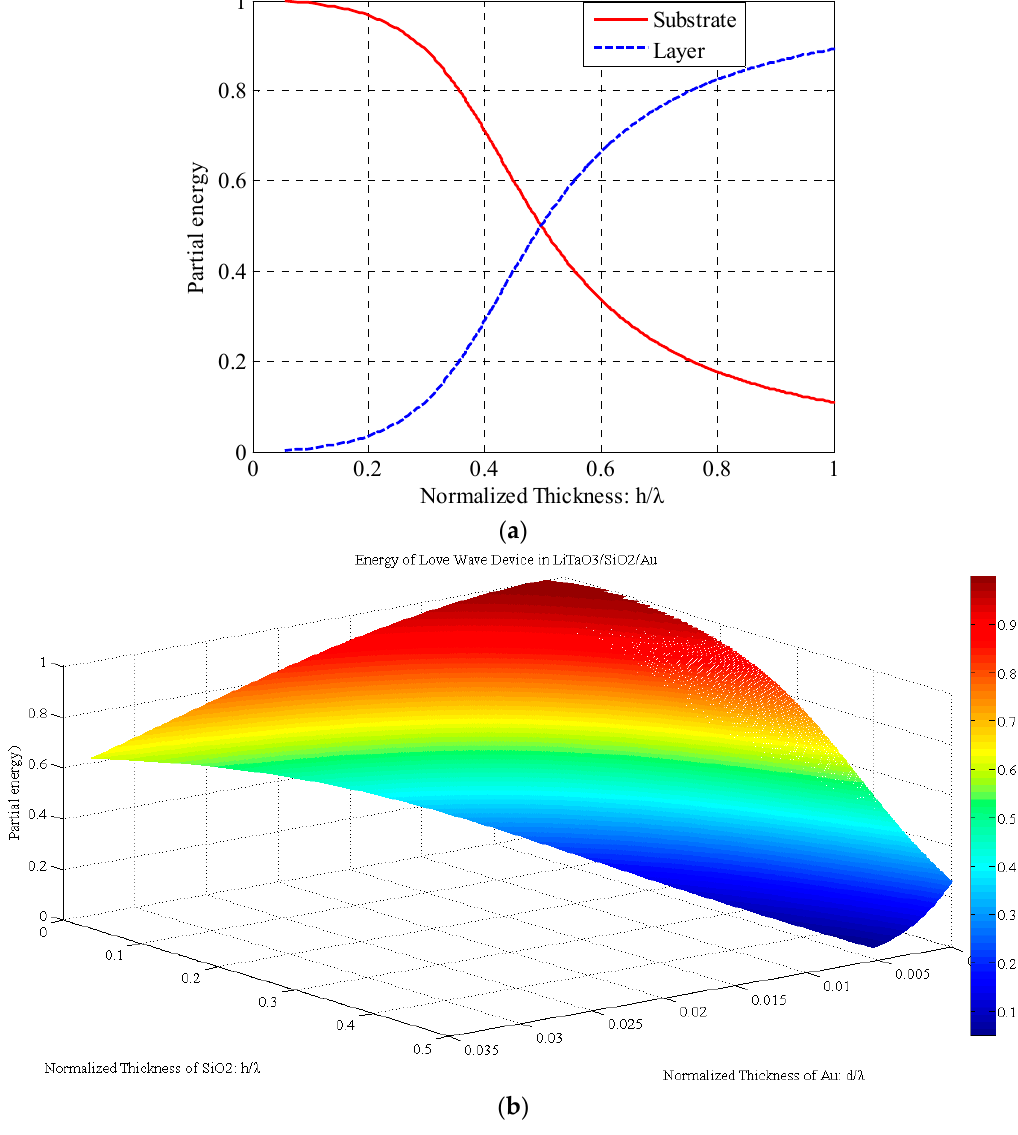
Figure 3. ( a ) Partial energy of Love wave in LiTaO 3 /SiO 2 device; ( b ) Partial energy of substrate in LiTaO 3 /SiO 2 /Au device.